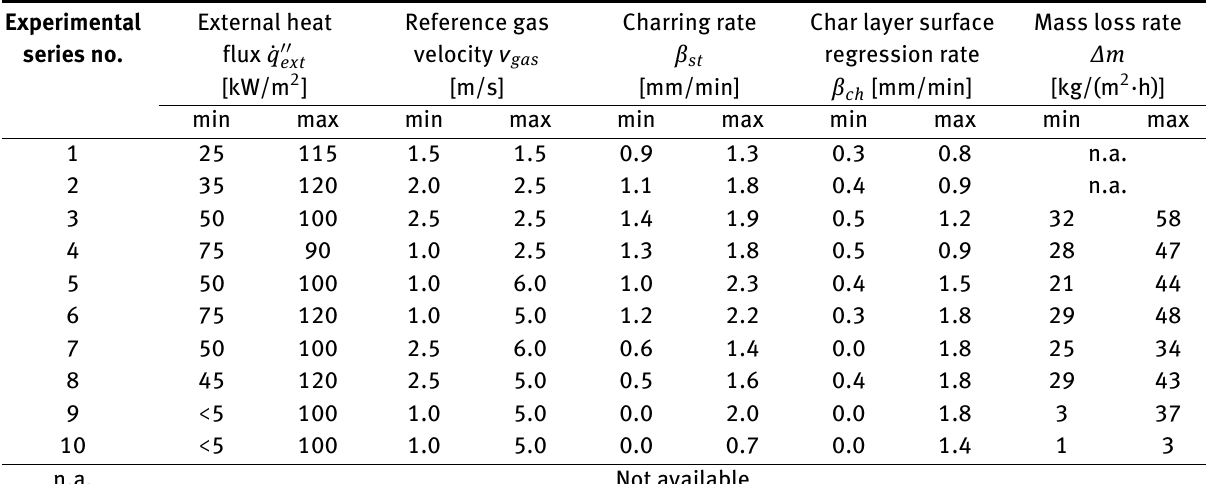
n.a. Not available